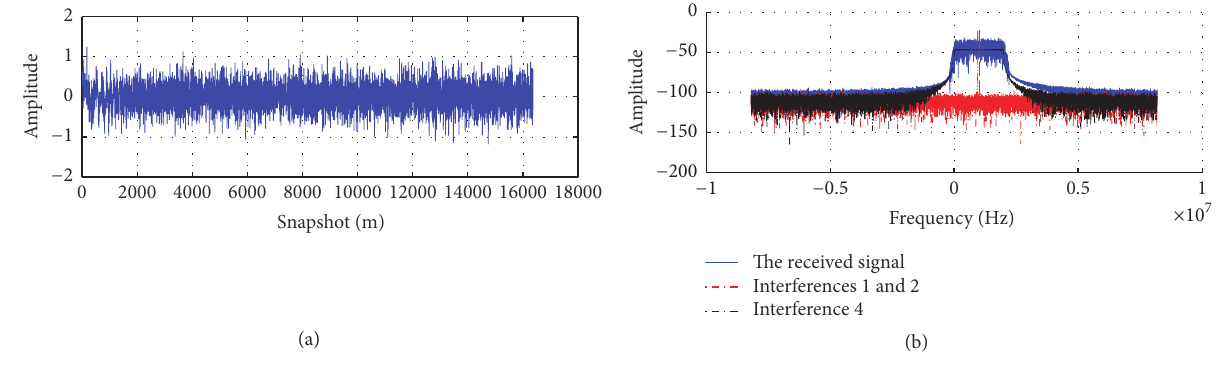
Figure 5: Characteristic of received signals.